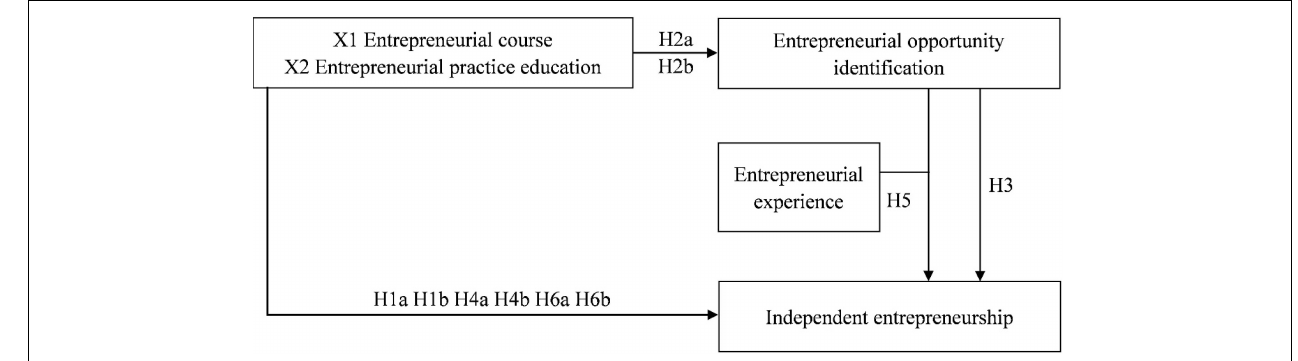
FIGURE 1 | Theoretical model.